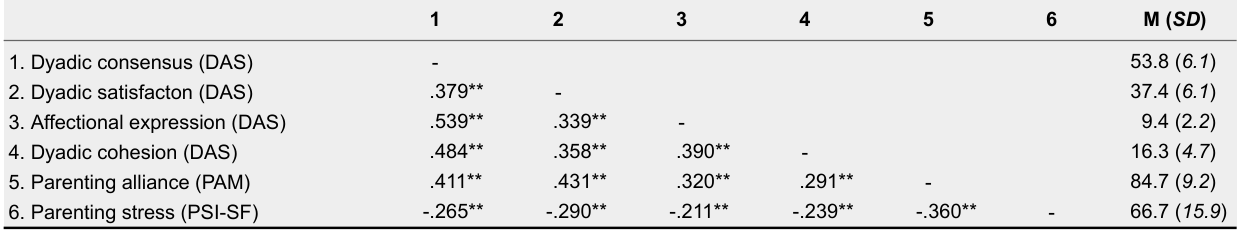
Descriptive Statistics and Correlations for Marital Adjustment (DAS), Parenting Alliance (PAM), and Parenting Stress (PSI-SF) in Fathers (N = 236)